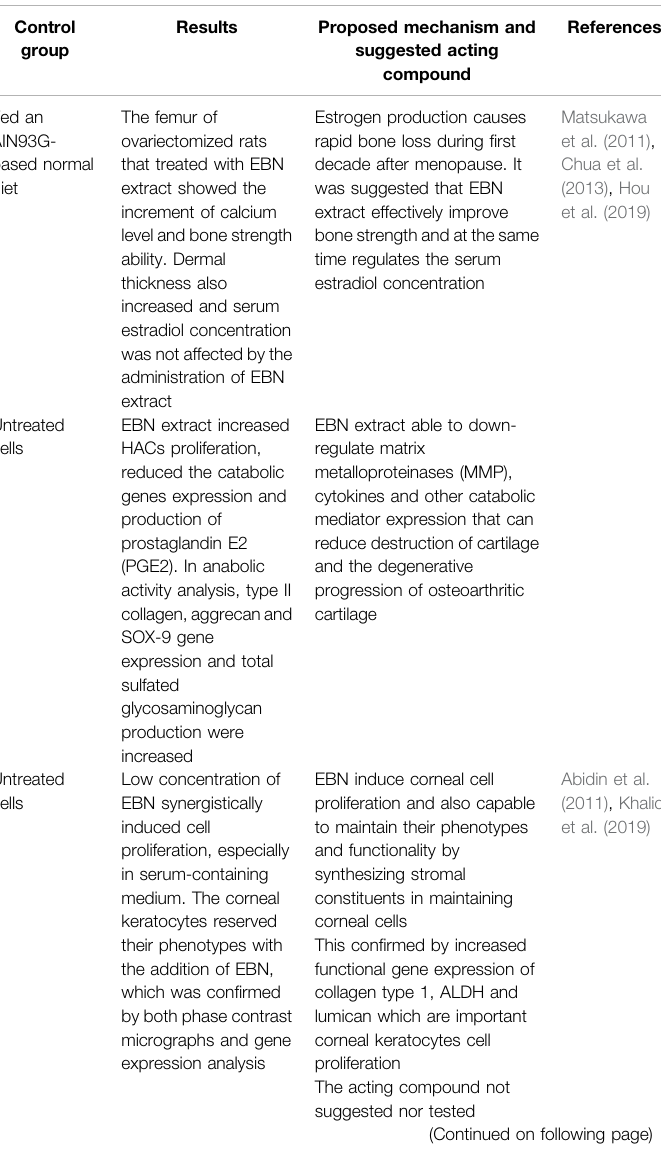
TABLE 1 | ( Continued ) Summary of studied effects using EBN